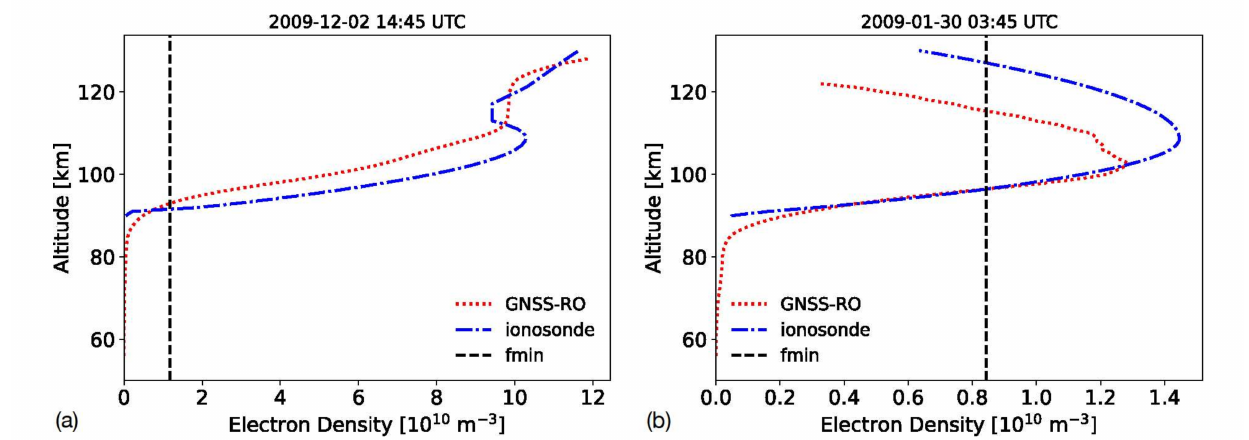
Figure 14. Example electron density profiles for the GNSS-RO and ionosonde measurements. The vertical line corresponds to the minimum return frequency observed by ionosondes, f min . Plot ( a ) corresponds to a daytime profile, while ( b ) shows a nighttime